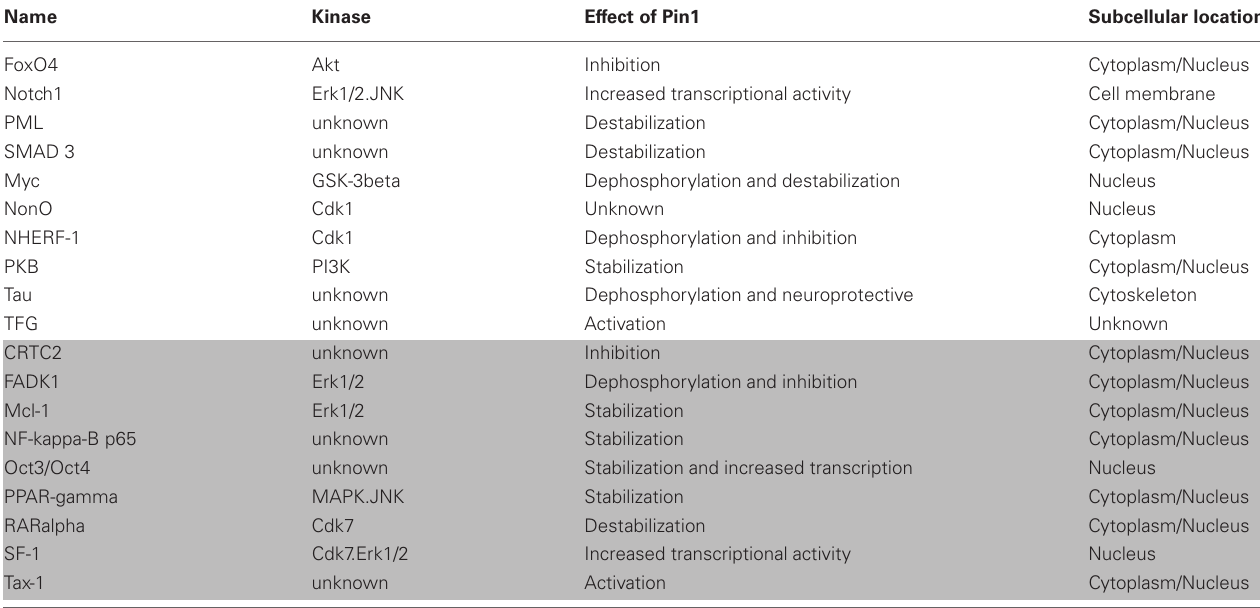
Table 1 | Pin1 substrates containing one or more binding sites with a proline in the + 1